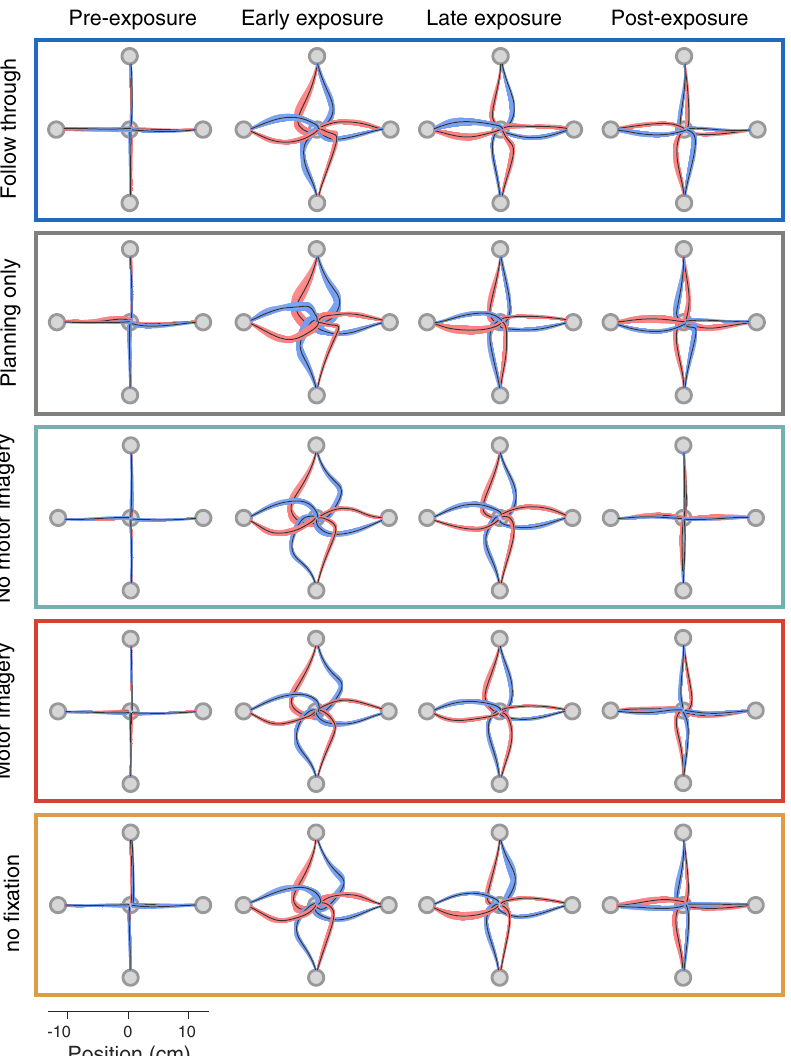
Figure 3. Kinematics across groups for different phases of the experiment. Hand paths are shown from each starting location to the central target for all groups across four different phases of the experiment. Paths show the mean ± s.e. across participants, for pre-exposure (last block), early exposure (first block), late exposure (last block), and post-exposure (first block). The colors indicate the field direction (blue for CCW and red for